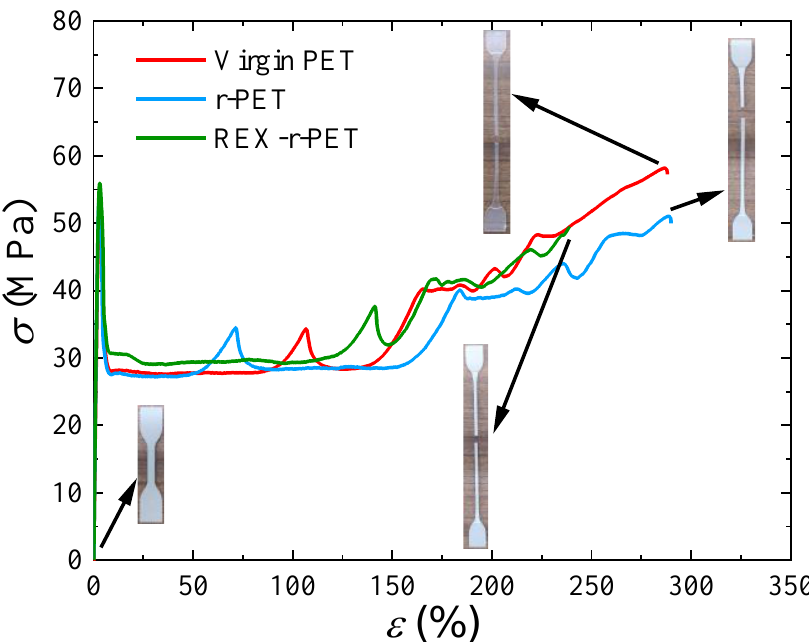
Figure 12. Stress–strain curves for virgin PET, r-PET, and REX-r-PET.